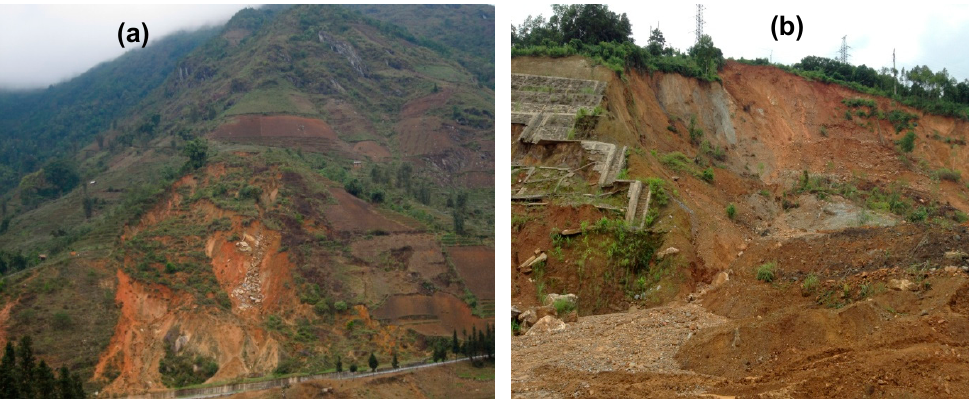
Figure 3. Two photos of landslides in the study area: ( a ) Landslide at the Mong Sen area and ( b ) Landslide at Km 7 Lao Cai. The two photos were taken by Xuan-Luan Truong in August 2014.